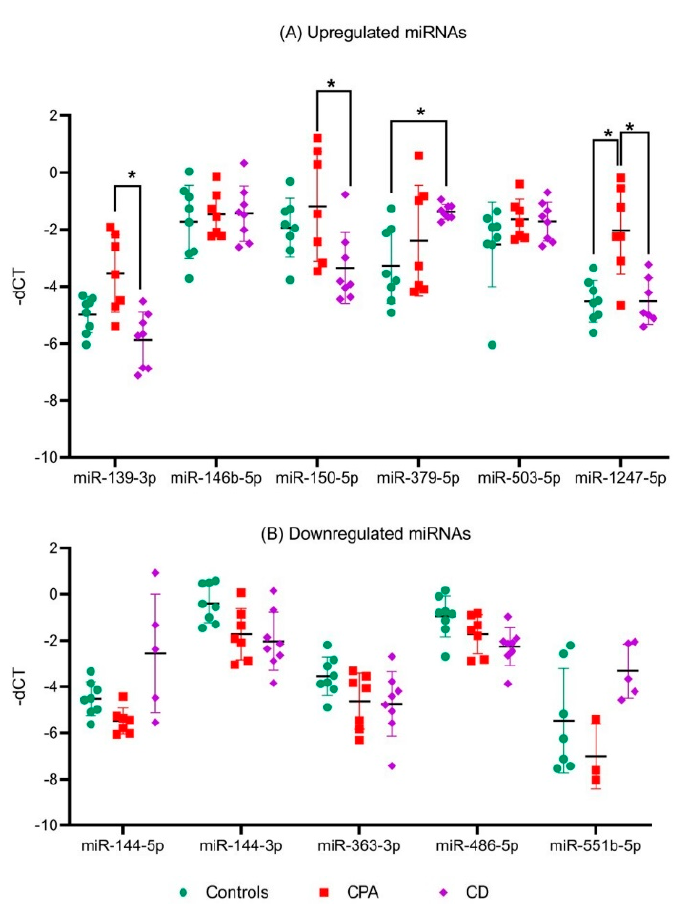
Figure 3. QPCR analyses of significant miRNAs from sequencing analyses. Data are represented as mean ± standard deviation (SD) of − dCT values: ( A ) Expression analysis of significantly upregulated miRNAs; ( B ) Expression analysis of common significantly downregulated miRNAs. Housekeeping gene: miR-16-5p. Statistics: ANOVA test with Bonferroni correction to detect significant differences between patient groups with at least a significance of p -value < 0.05 (*).